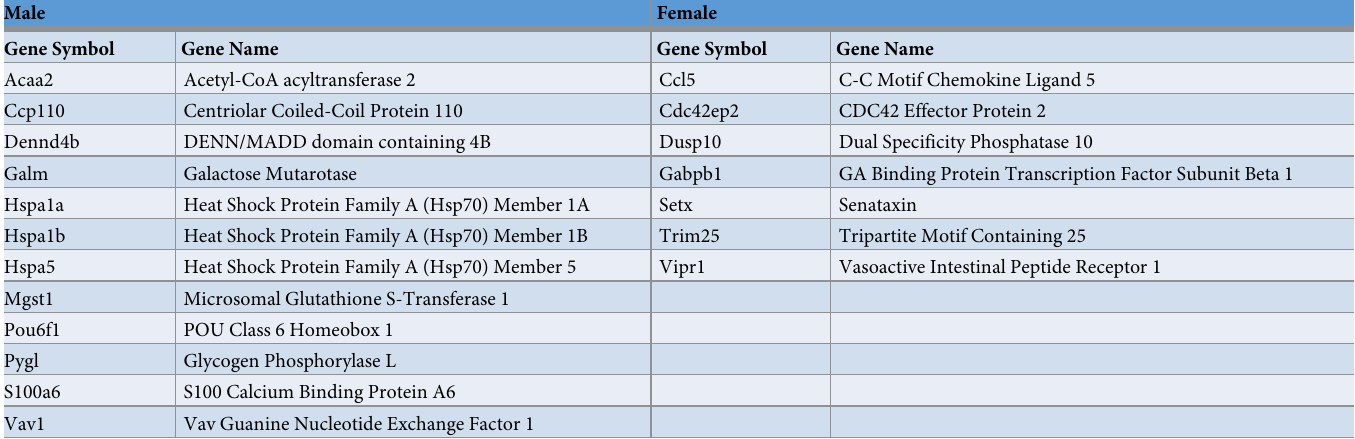
Table 2. Genes Differentially Expressed between CIE and Air C57Bl/6J Mice in Amygdala with Expression Levels that are also Correlated between Blood and Amygdala. Male